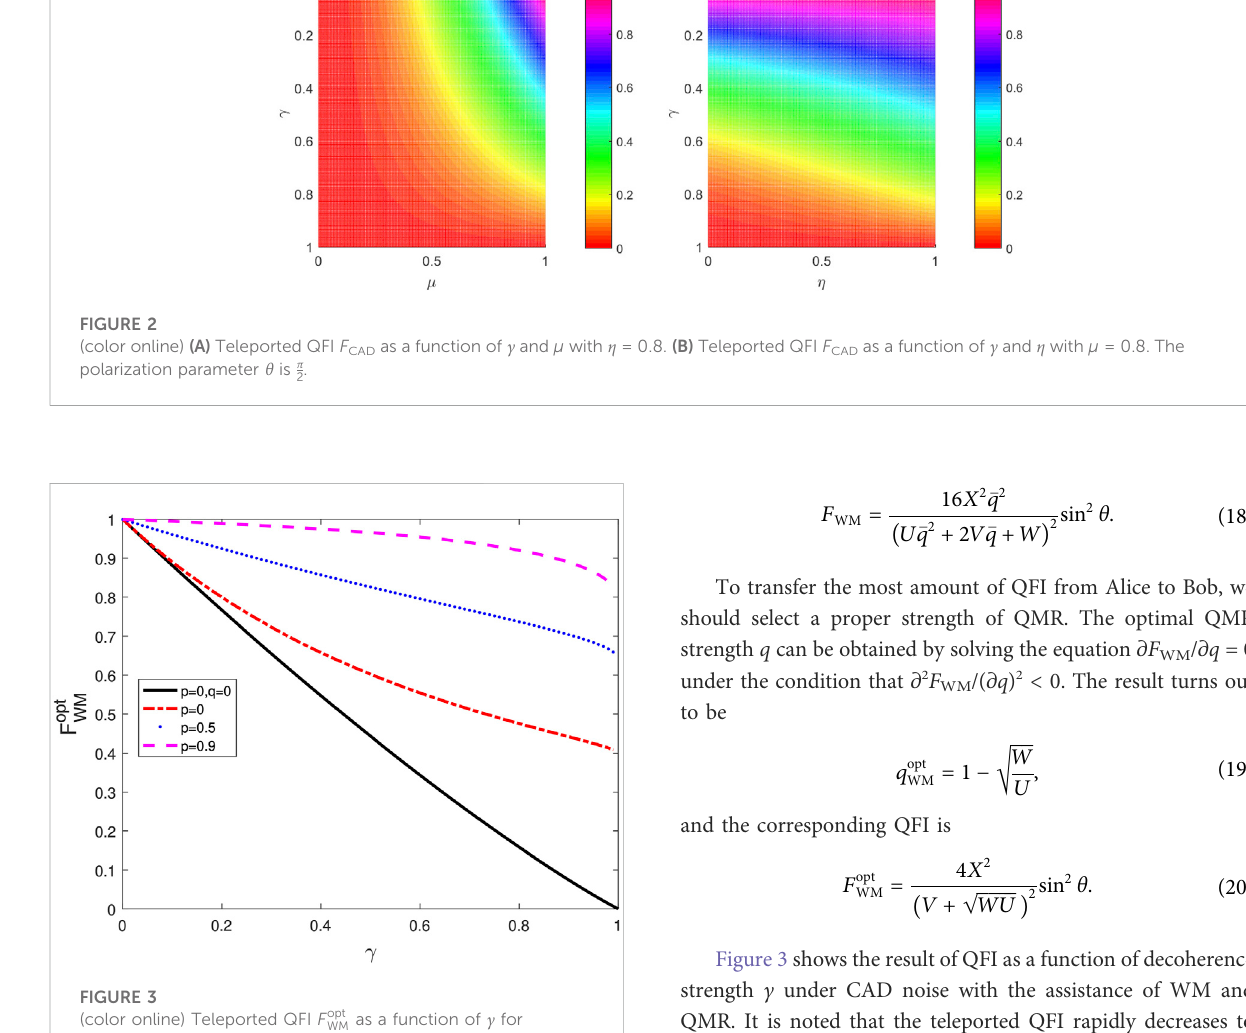
FIGURE 3 (color online) Teleported QFI F opt WM as a function of γ for different p with μ = 1 and η = 0.8. When p = 0, p = 0.5 and p = 0.9, the corresponding strength of QMR is q (cid:2) q opt WM . The polarization parameter θ is π